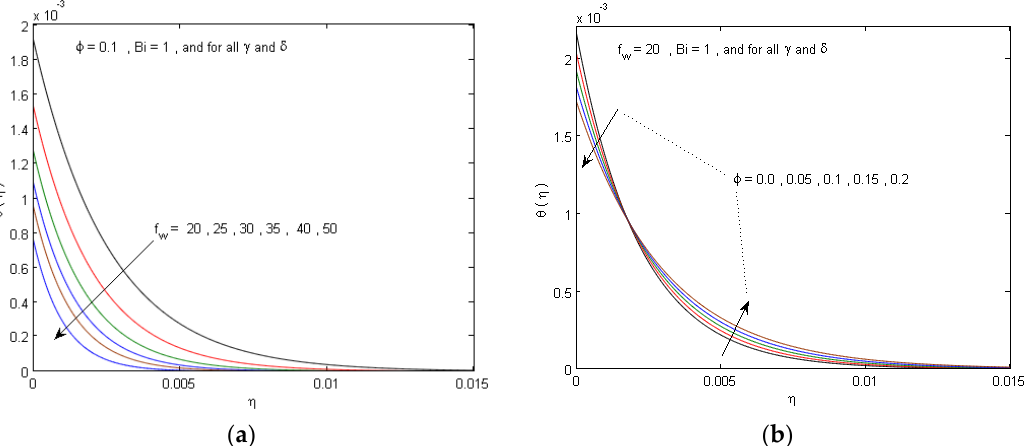
Figure 7. Temperature profiles for different values of ( a ) suction parameter f w and ( b ) soild volume fraction parameter φ .